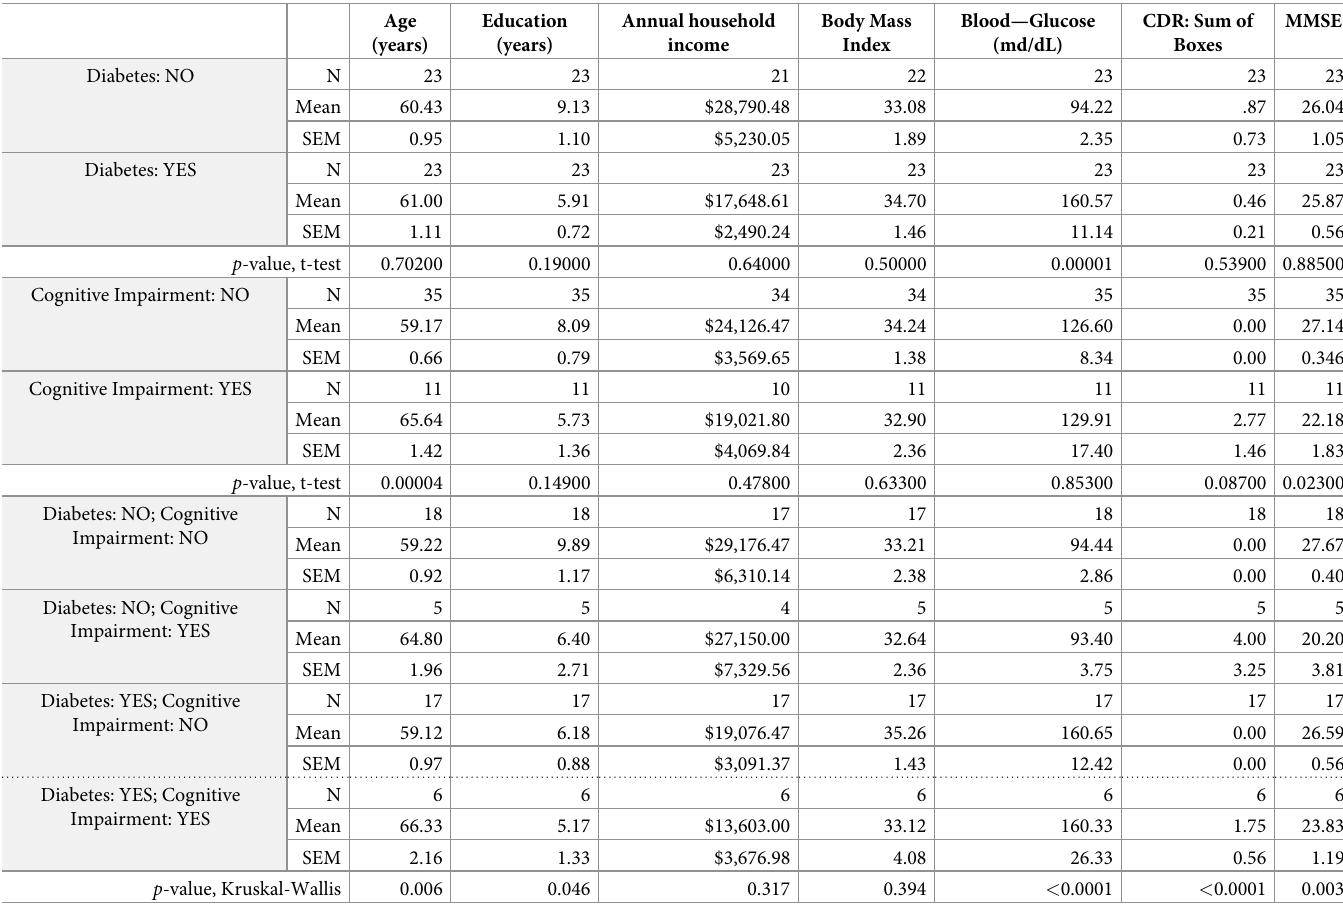
Table 1. Descriptive statistics of female, Mexican American (self-described) subject cohort. Variable sample sizes for each category are due to missing subject responses. CDR, clinical dementia rating (ranges from 0–18, negatively correlated with cognitive function); MMSE, mini mental state exam (ranges from 0–30, positively correlated with cognitive